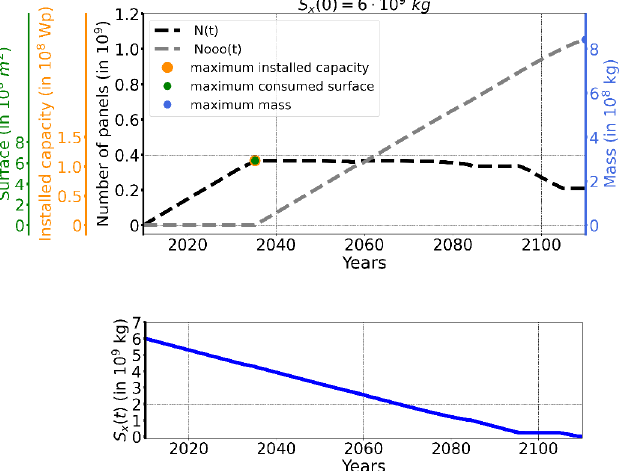
Fig. 6. Operational panels (black dashed line) and out of order panels (gray dashed line) (up), and stock of raw material (blue line) as functions of time, following the scenario B with S x (0) = 6 billion kilograms. and t f = 100 years.